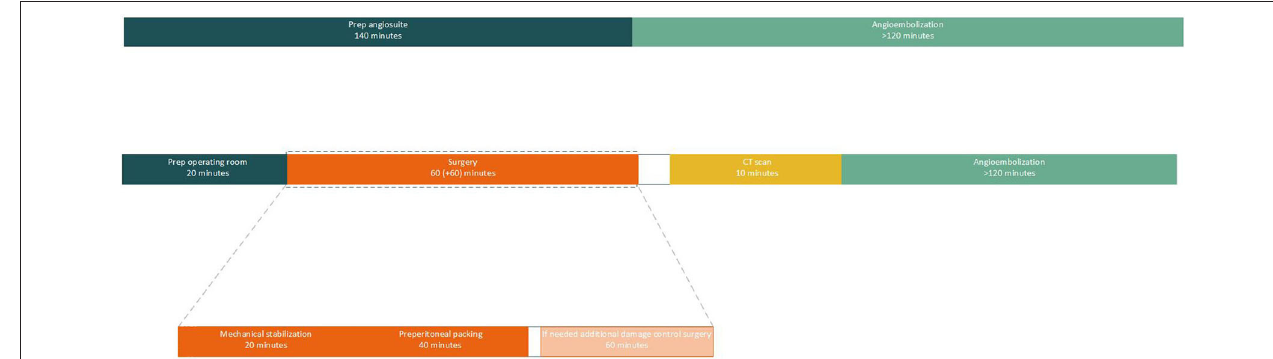
FIGURE 4 | An overview of the time line of both angioembolization and mechanical stabilization, pelvic packing, CT scan and additional angioembolization. Procedural times and prepping times are extracted from real life cases and extracted from Burlew et al. (14). This overview shows that the time needed for prepping an operating theater and performing mechanical stabilization, preperitoneal packing and if needed additional damage control surgery, can be used to prepare the angio suite for additional angioembolization if required. It also becomes evident that preparing an angio suite causes an unnecessary delay in treatment in hemodynamically unstable